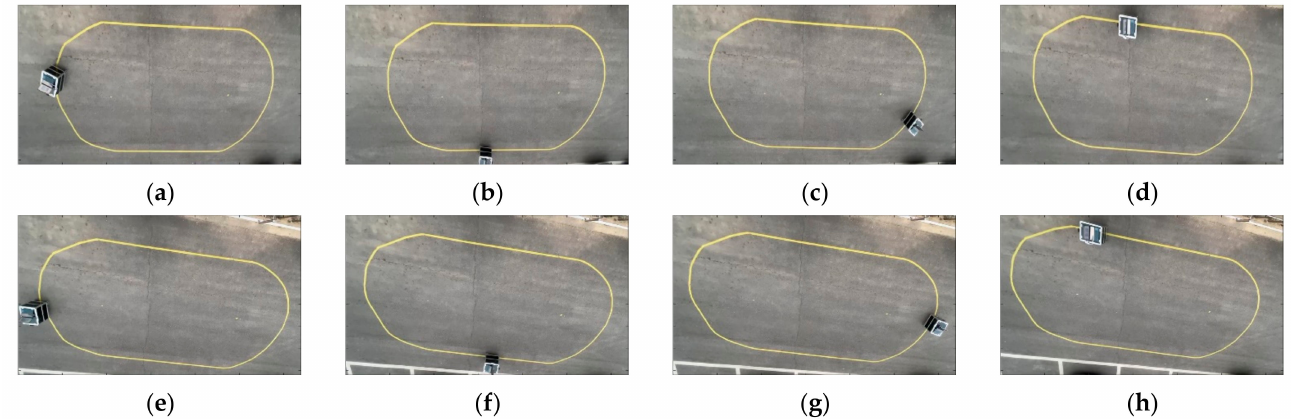
Figure 25. Ellipse path tracking scenario results; ( a ) LQR-based actual experiment image—600th frame; ( b ) LQR-based actual experiment image—1200th frame; ( c ) LQR-based actual experiment image—1800th frame; ( d ) LQR-based actual experiment image—2800th frame; ( e ) SMC-based actual experiment image— 600th frame; ( f ) SMC-based actual experiment image—1200th frame; ( g ) SMC-based actual experiment image—1800th frame; ( h ) SMC-based actual experiment image—2600th